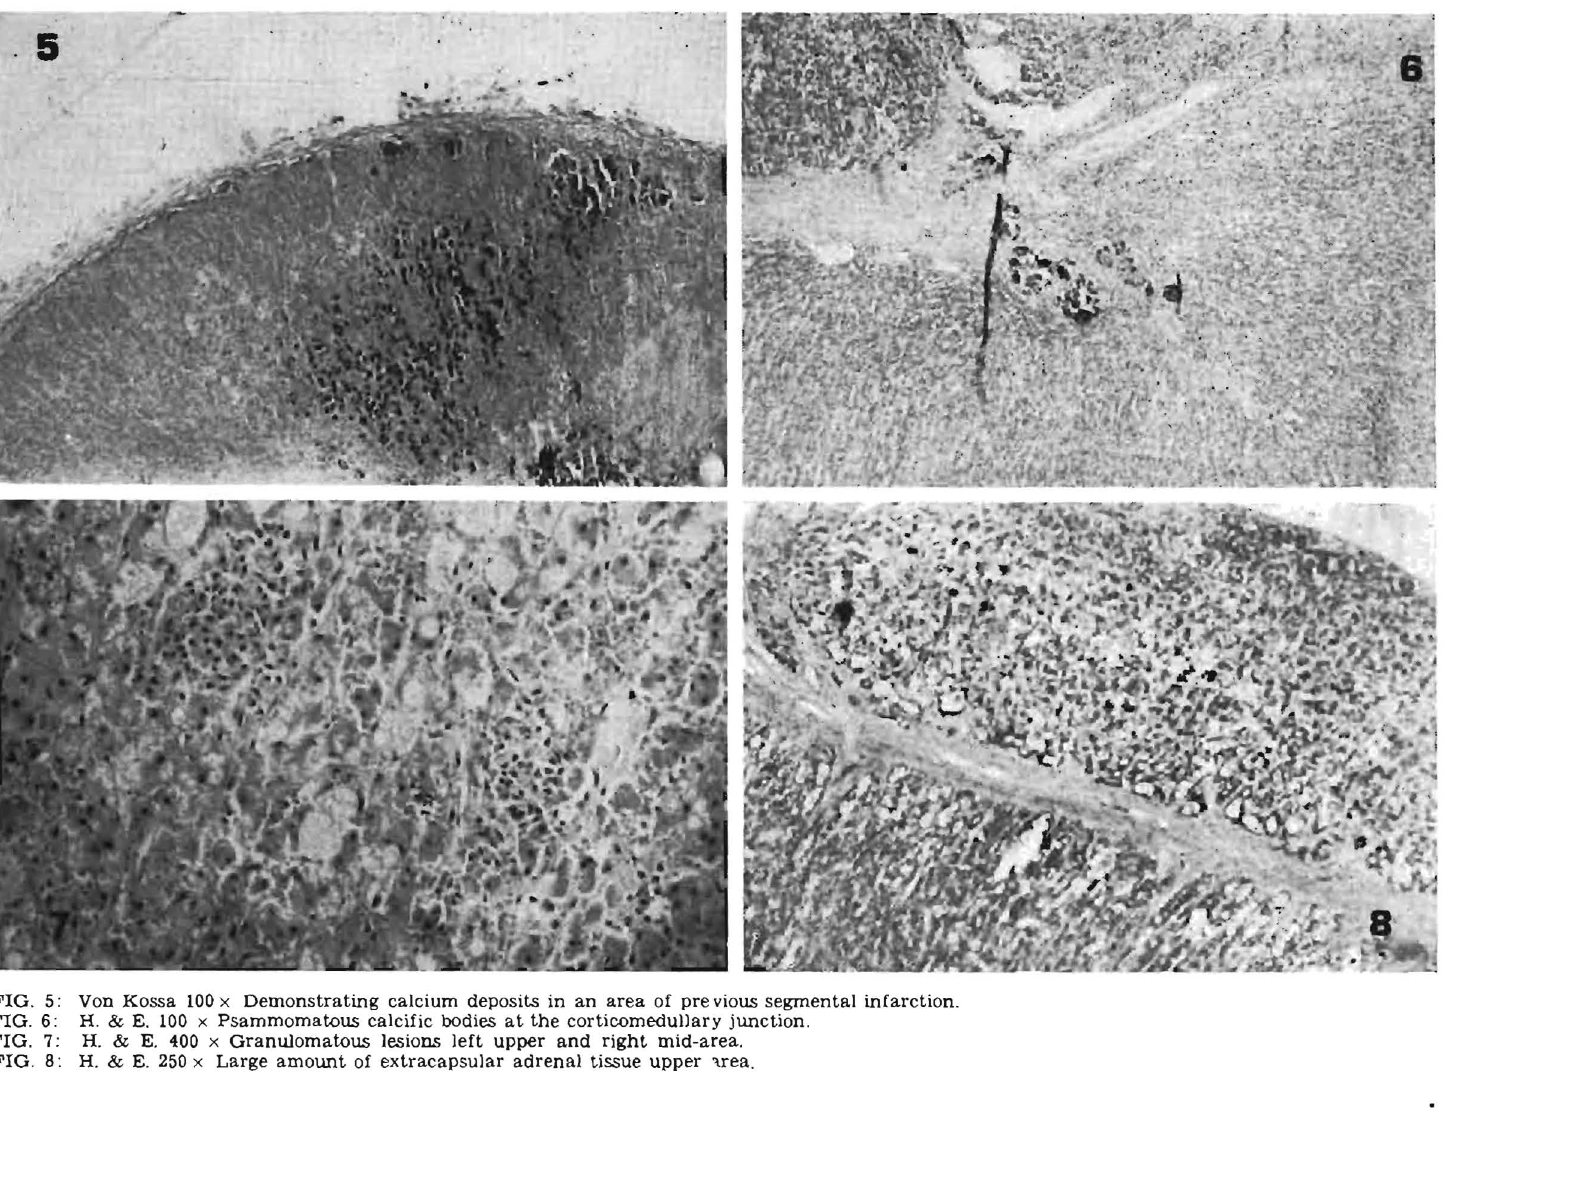
Von Kossa 100 x Demonstrating calcium deposits in an area of pre vious segmental infarction. FIG. 5: H. & E. 100 x Psammomatous calcific bodies at the corticomedulJary junction. FIG. 6: FIG. 7: H. & E. 400 x Granulomatous lesions left upper and right mid-area. H. & E. 250 x Large amount of extracapsular adrenal tissue upper FIG. 8: